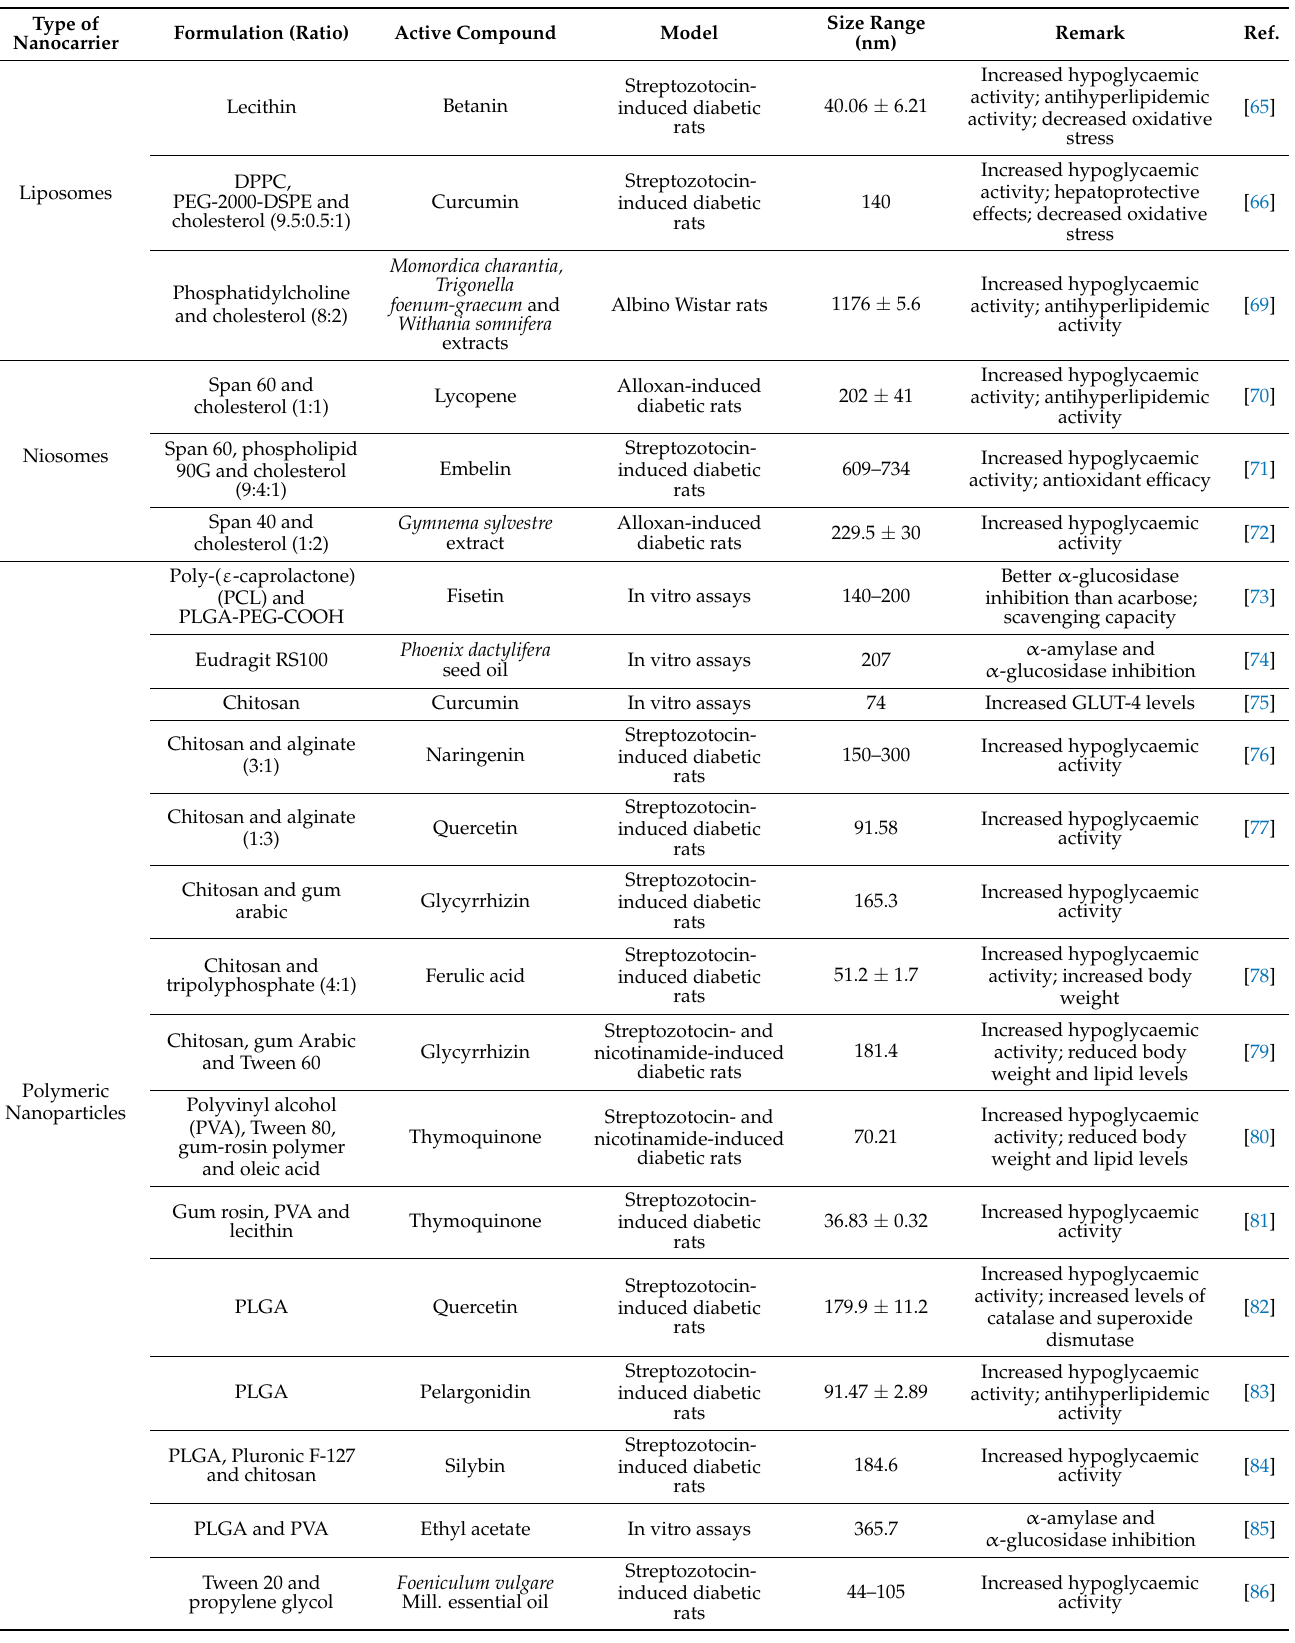
Table 2. Nanoformulations for plant-based antidiabetic